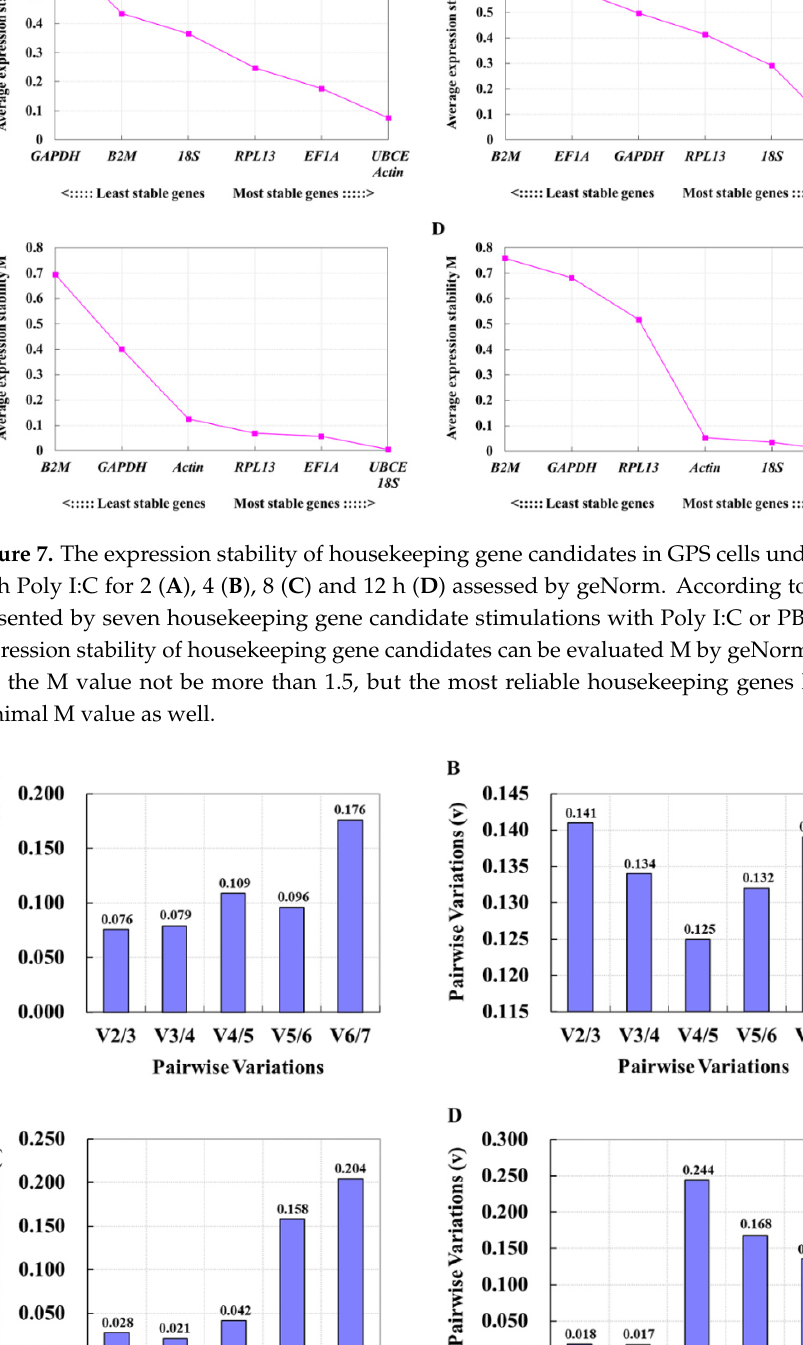
Figure 9. The expression stability of housekeeping gene candidates in GPHK cells under stimulation with Poly I:C for 2 ( A ), 4 ( B ), 8 ( C ) and 12 h ( D ) assessed by geNorm. According to the C t values presented by seven housekeeping gene candidate stimulations with Poly I:C or PBS, the average expression stability of housekeeping gene candidates can be evaluated M by geNorm, and not only can the M value not be more than 1.5, but the most reliable housekeeping genes have the most minimal M value as well.